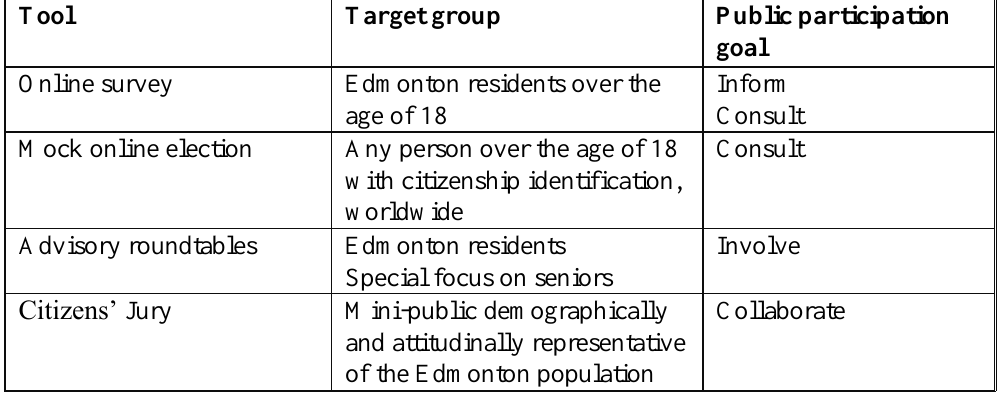
Table 2 Participation tools used in Edmonton and their intended public participation